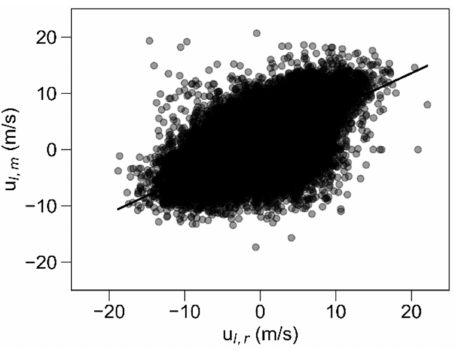
Figure A1. Correlation between reproduced and measured cross-shore wind velocities. The black line represents the linear correlation estimated by the least-squares